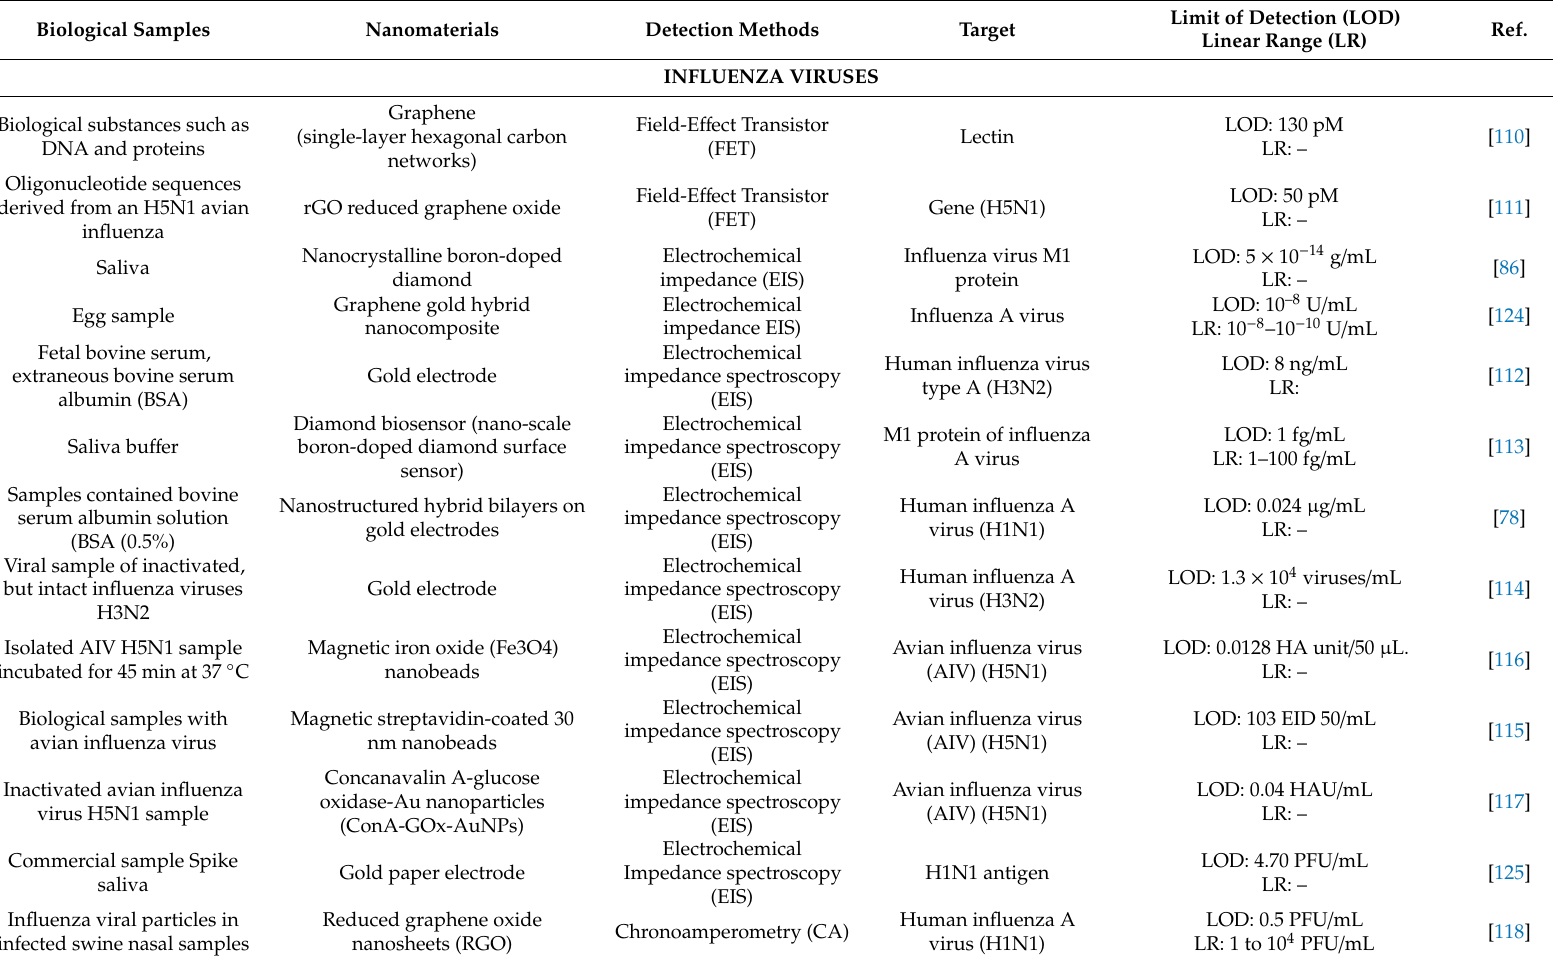
Table 3. Electrochemical based nanobiosensors of epidemic / pandemic influenza viruses in comparison with coronaviruses (SARS / MERS-CoV and 2019-nCoV). Biological